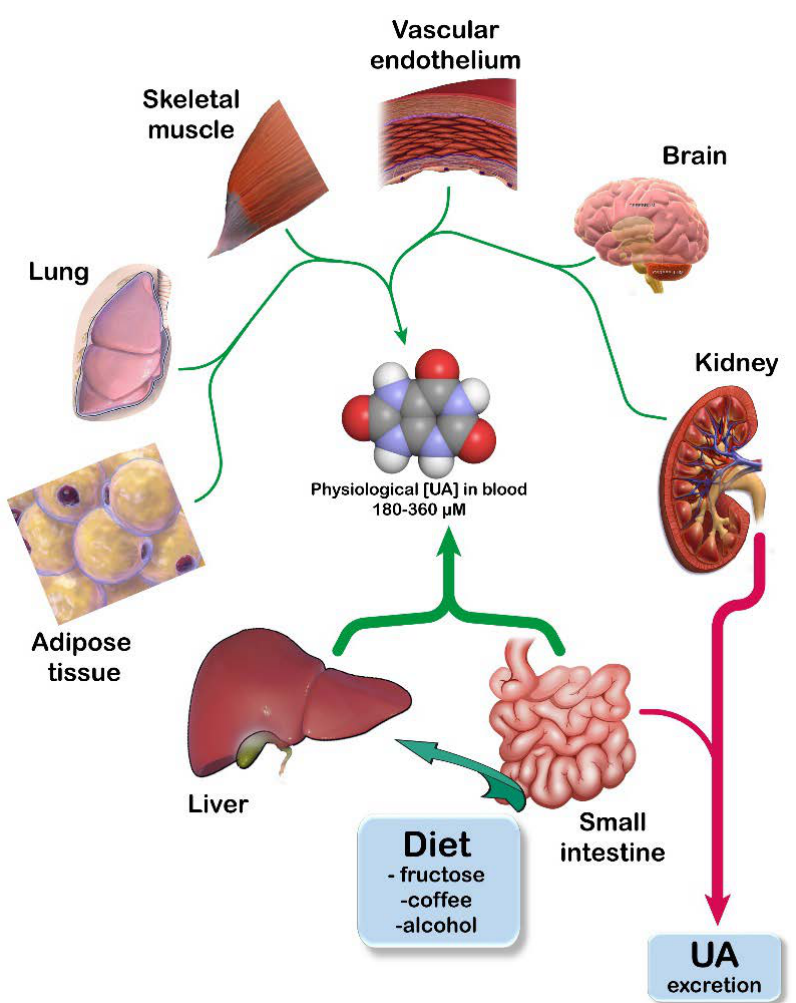
Figure 1. Uric acid (UA) homeostasis. UA is the final product of the catabolism of purine bases. UA homeostasis is maintained through a correct balance of its production (green arrows) and its excretion (red arrows). UA production occurs mainly in those tissues that express high levels of xanthine oxidoreductase (the enzyme catalyzing the last two steps of its biosynthesis). Kidneys account for about two thirds of the daily excretion of UA, while gut removes the remaining one third into the feces. Adapted from [27].